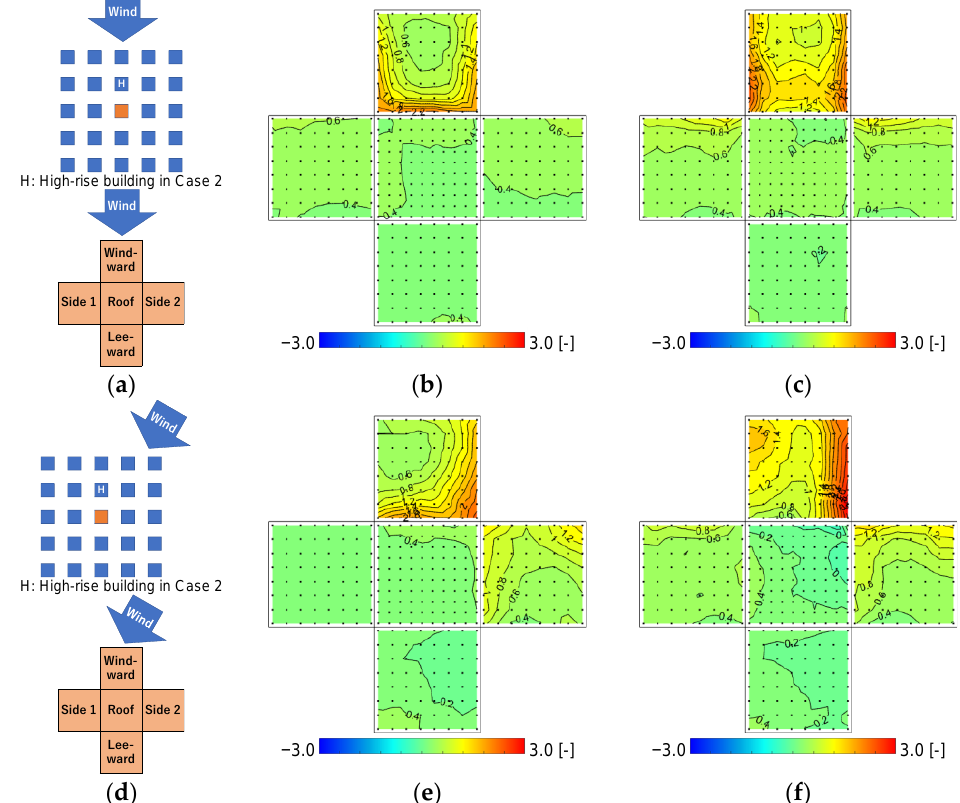
Figure 8. Positive peakC p ; ( a ) building model arrangement and prevailing wind direction for ( b , c ); ( b ) wind direction of 0 ◦ in Case 0 with no high-rise building; ( c ) wind direction of 0 ◦ in Case 2 with a high-rise building next to the pressure measurement model; ( d ) building model arrangement and prevailing wind direction for ( e , f ); ( e ) wind direction of 30 ◦ in Case 0; ( f ) wind direction of 30 ◦ in Case